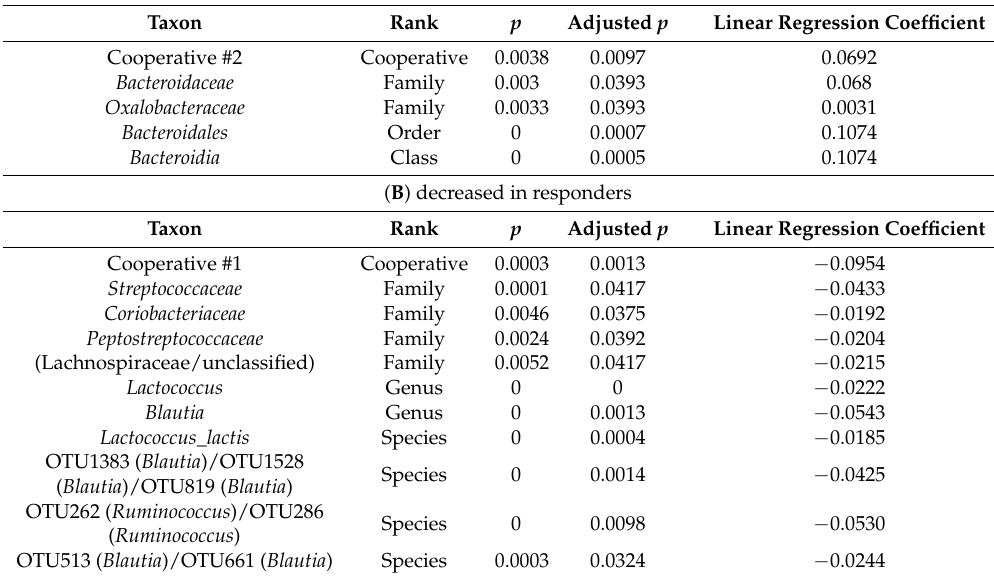
Table 1. Taxa and cooperatives differentially abundant in the gut microbiota of responders and non-responders before the FDP consumption. For each feature, beta-coefficient of linear model is shown. ( A ) Increased in responders; and ( B ) decreased in